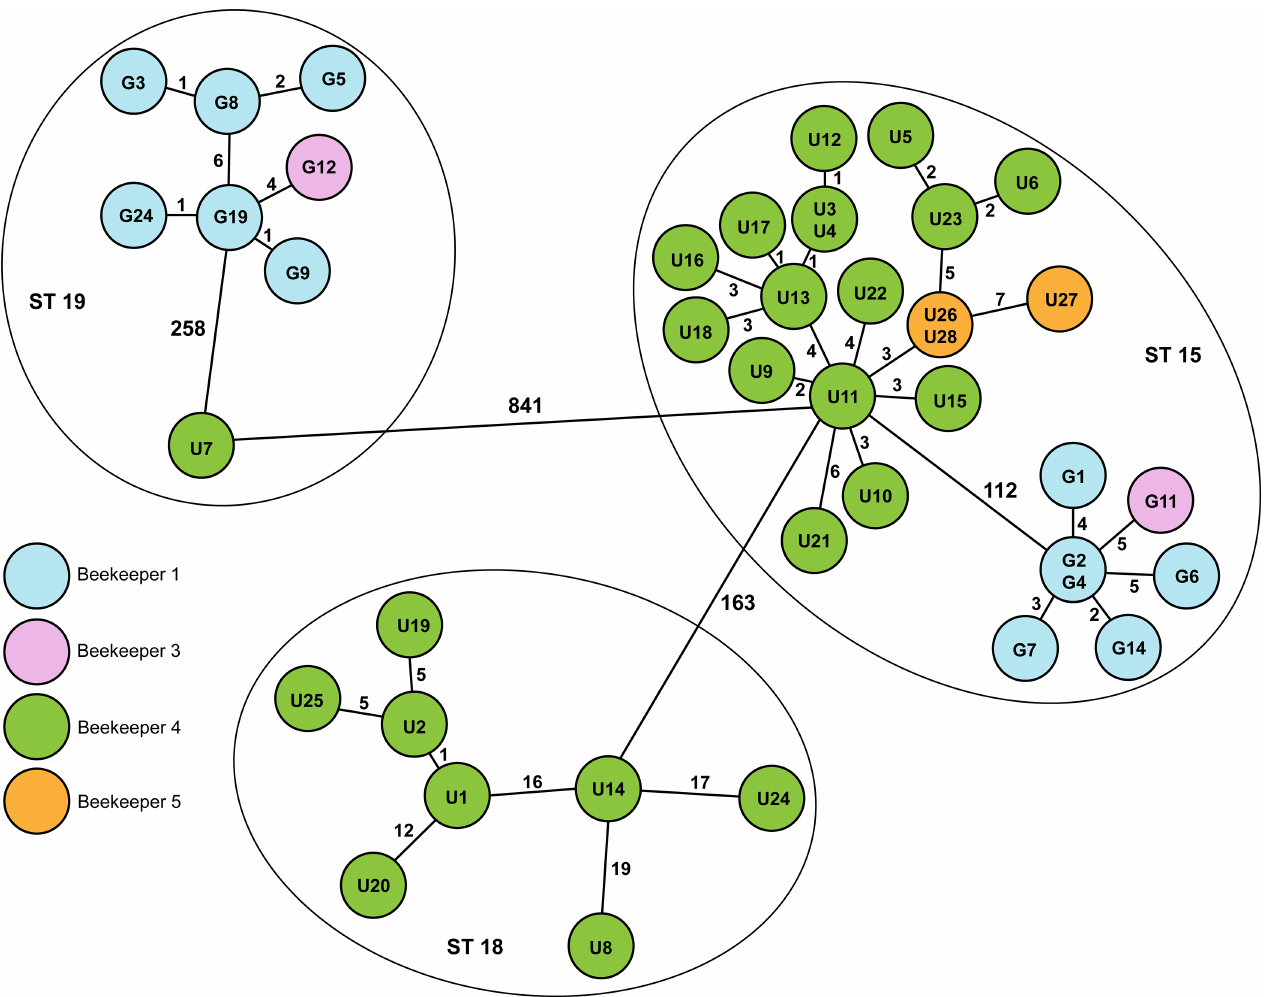
Fig 2. Core genome MLST results of ERIC I-type isolates from AFB outbreaks on Gotland (G) and from Uppland (U). Minimum spanning tree generatedin SeqSphere+ based on comparing the 3,052 genes present in the assembliesof the isolates. The numbersrepresent the numbers of alleledifferences betweengroups of isolates. The lengths of the lines are not proportional to the numberof differences. The colors indicate the origin of the isolates (the beekeeper/owner of the apiaries). The circles show which MLST sequencetype the isolates belongedto. The minimum spanning tree should not be over-interpreted as showingtransmissionroutes, only the level of